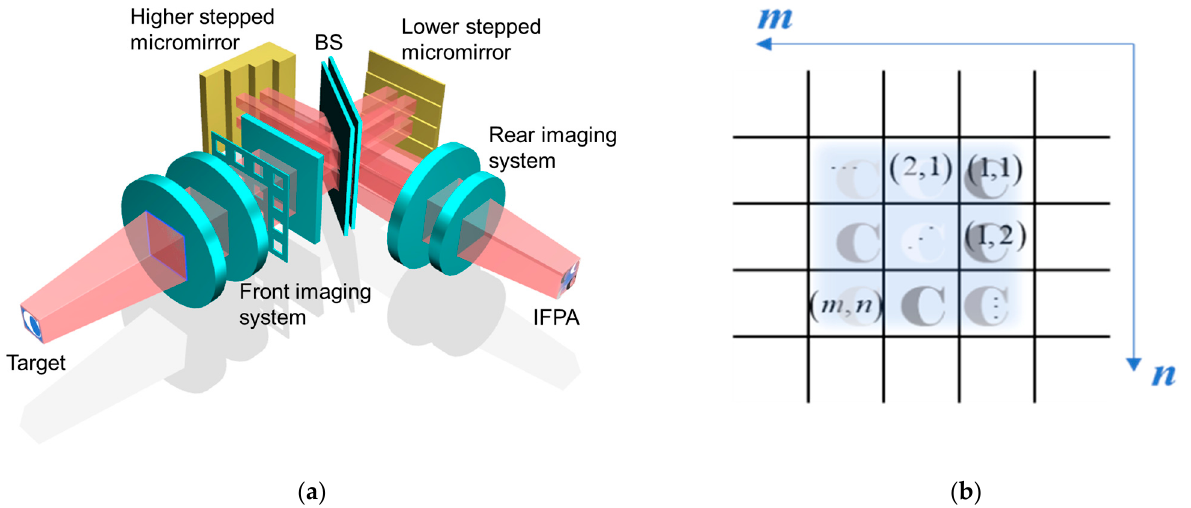
Figure 1. Explanation of the SIIFTS principle: ( a ) schematic diagram of the SIIFTS; ( b ) phase modulation units.